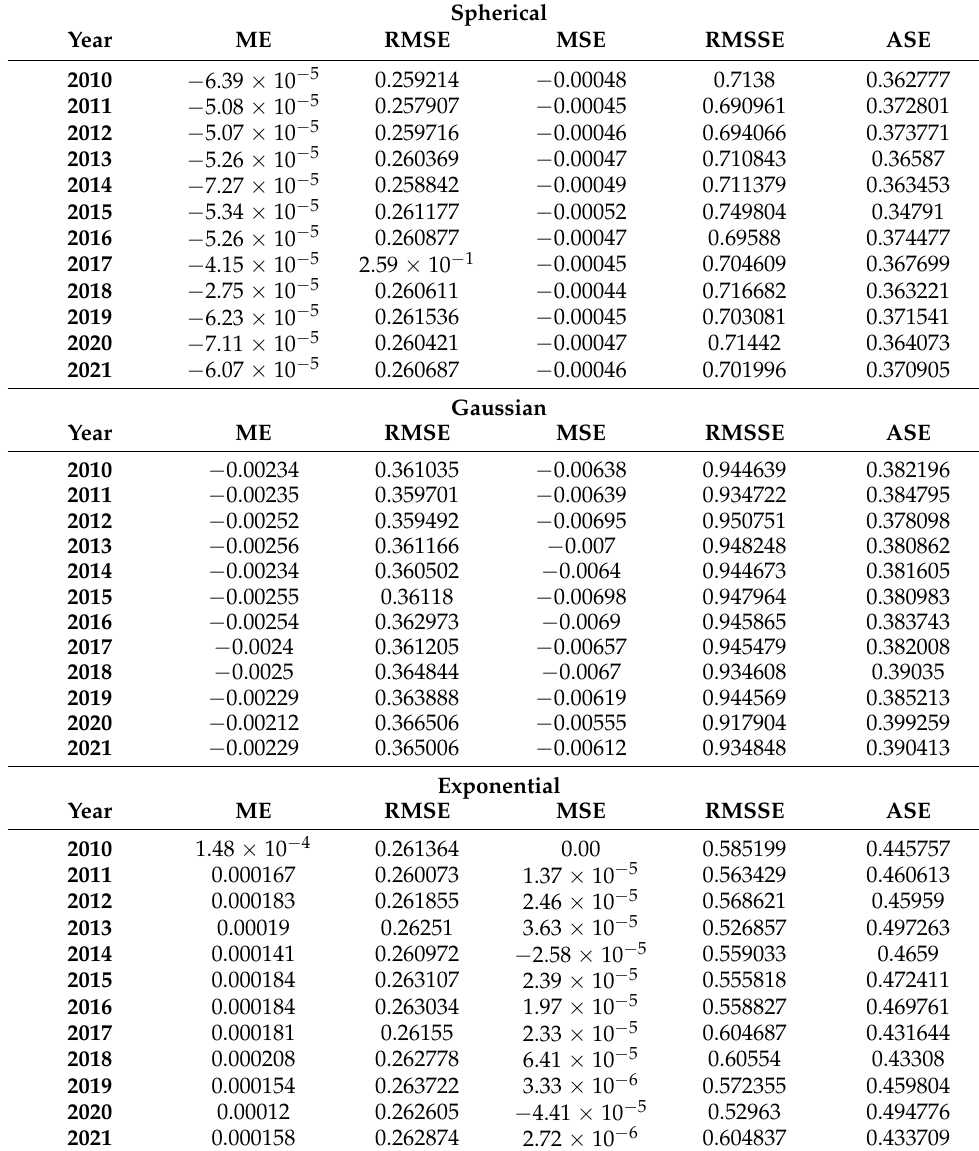
Table 2. Cross-validation for the tested geostatistical